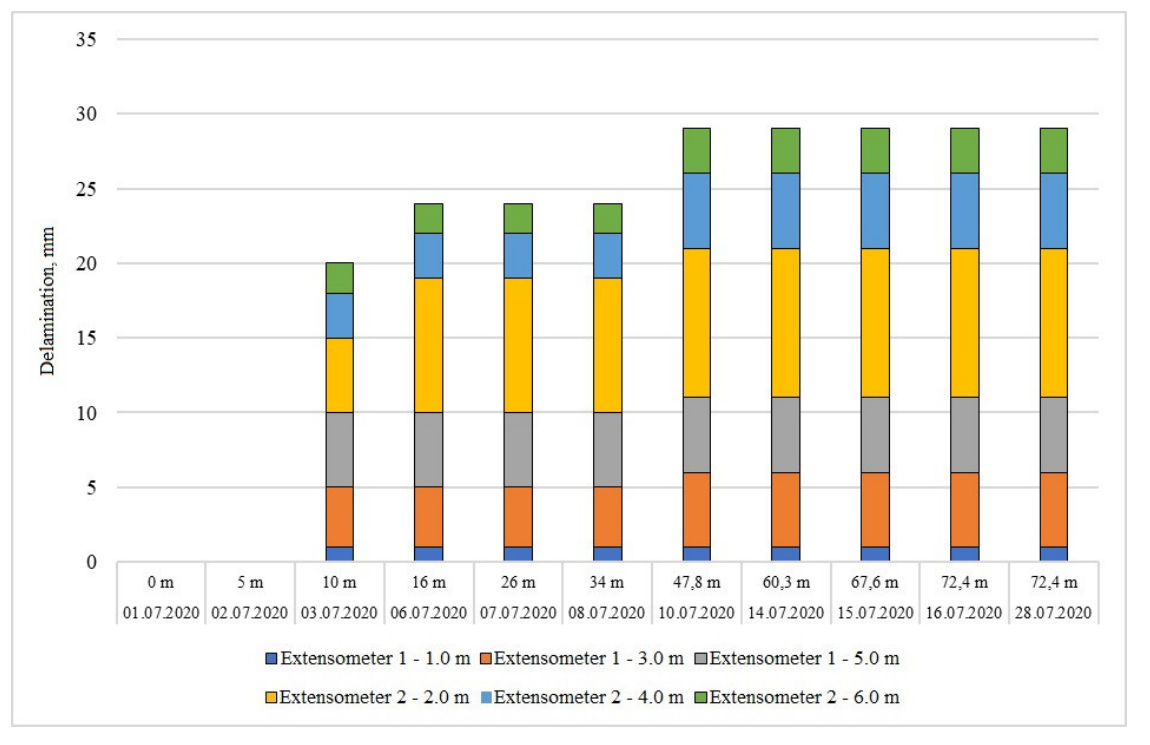
Figure A4. Roof delaminations measured using multilevel mechanical extensometer—periodic control station no. 5.